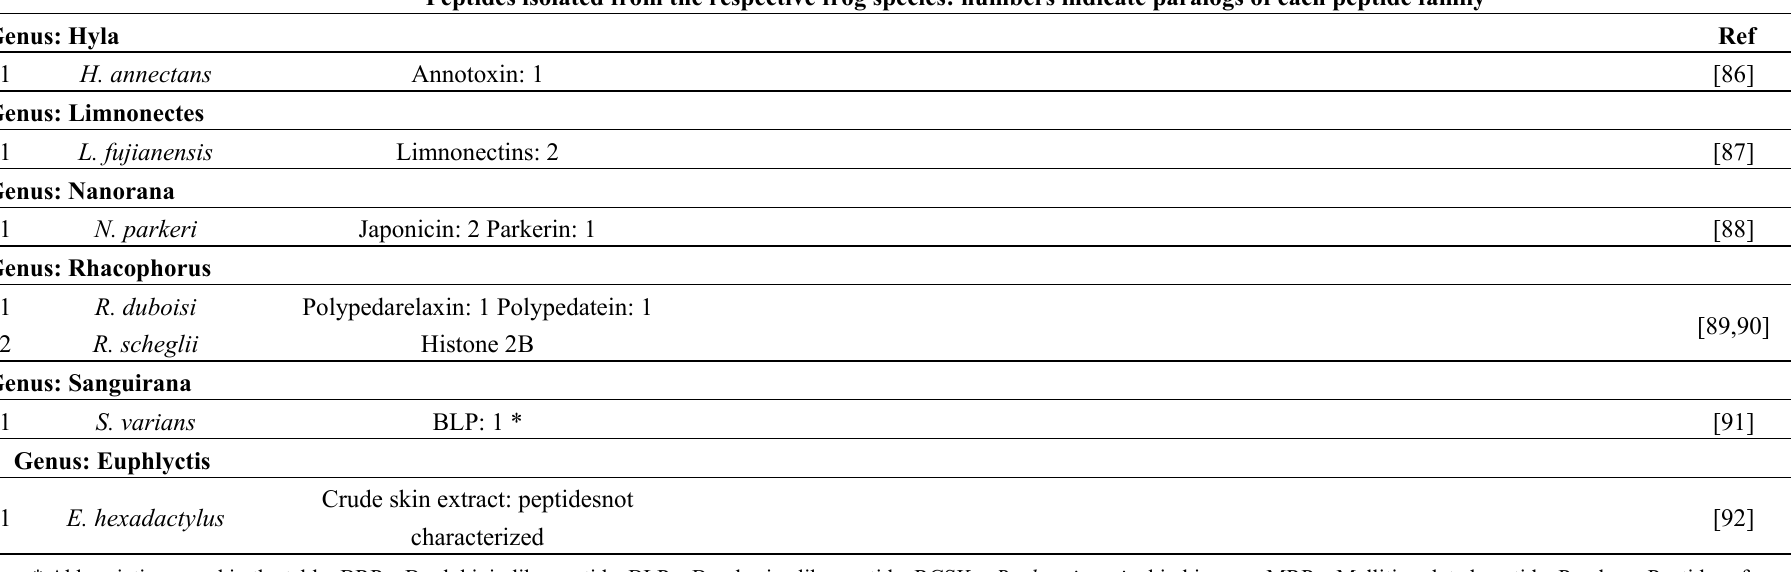
Table 1. Cont . Peptides isolated from the respective frog species: numbers indicate paralogs of each peptide